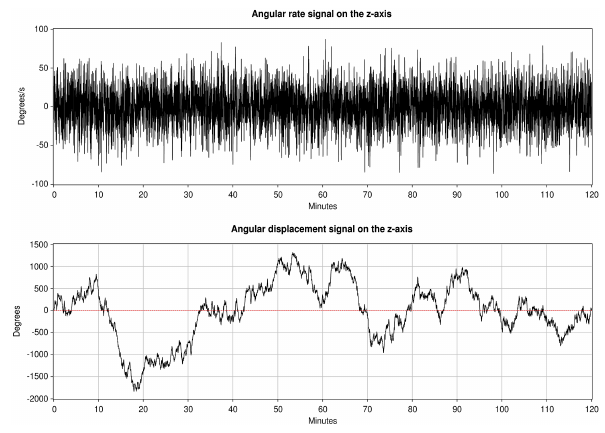
Figure 9. Signals recorded by a MEMS sensor during a random horizontal rotation for a period of